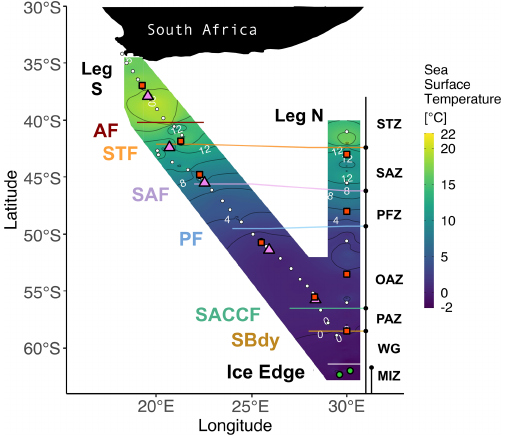
Figure 1. Winter 2017 cruise track overlaid on sea surface tem- perature (SST) measured by the hull-mounted thermosalinograph. The underway (leg S) and CTD (leg N) stations are indicated by white circles. Stations at which net primary production (NPP), ni- trogen uptake, and ammonium oxidation experiments were con- ducted are denoted by red squares. The pink triangles indicate sta- tions where only NPP experiments were conducted, and the green circles show stations where only ammonium oxidation was mea- sured. Solid lines indicate the positions of the fronts, identified from measurements of temperature and salinity. Abbreviations for fronts: AF – Agulhas Front ( ∼ 40 . 2 ◦ S); STF – Subtropical Front ( ∼ 42 . 1 ◦ S); SAF – Subantarctic Front ( ∼ 45 . 6 ◦ S); PF – Polar Front ( ∼ 49 . 5 ◦ S); SACCF – Southern Antarctic Circumpolar Cur- rent Front ( ∼ 56 . 5 ◦ S); SBDY – Southern Boundary ( ∼ 58 . 5 ◦ S). Abbreviations for zones: STZ – Subtropical Zone; SAZ – Sub- antarctic Zone; PFZ – Polar Frontal Zone; OAZ – Open Antarc- tic Zone; PAZ – Polar Antarctic Zone; WG – Weddell Gyre; MIZ – Marginal Ice Zone. Together, the OAZ and PAZ constitute the Antarctic Zone (AZ). See Sect. S1 for detailed definitions of the fronts and zones. Figure produced using the package ggplot2 (Wick- ham,